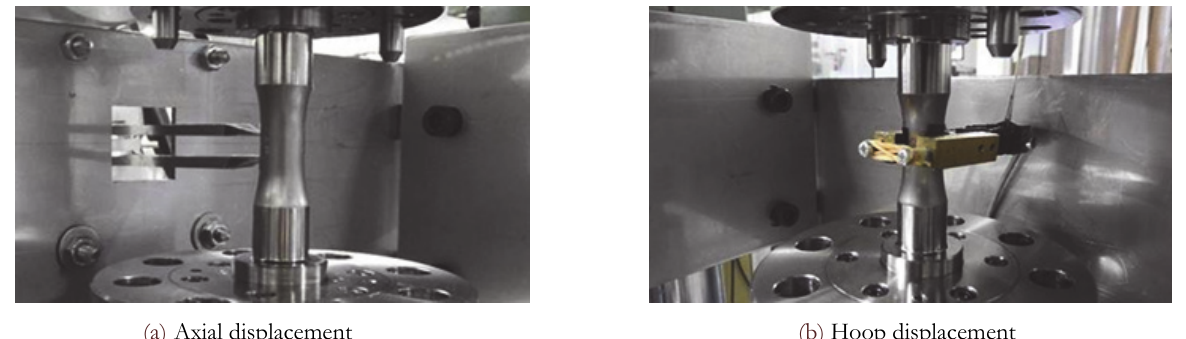
Figure 3: Extensometers to measure axial and hoop